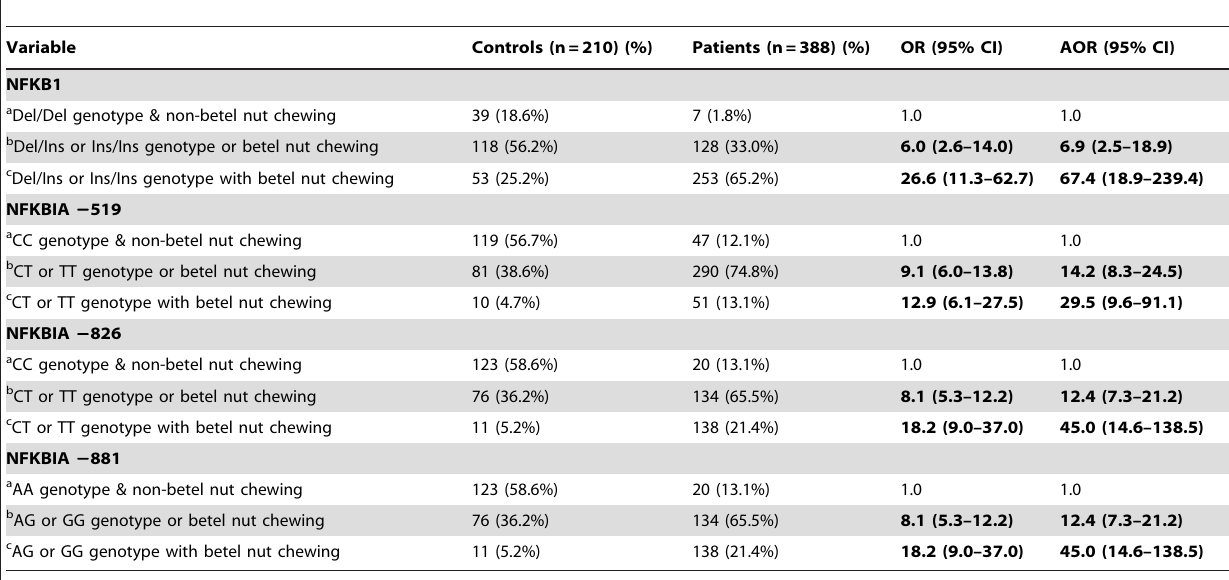
Table 3. Adjusted odds ratio (AOR) and 95% CI for oral cancer associated with NFKB and NFKBIA genotypic frequencies and betel nut chewing among 598